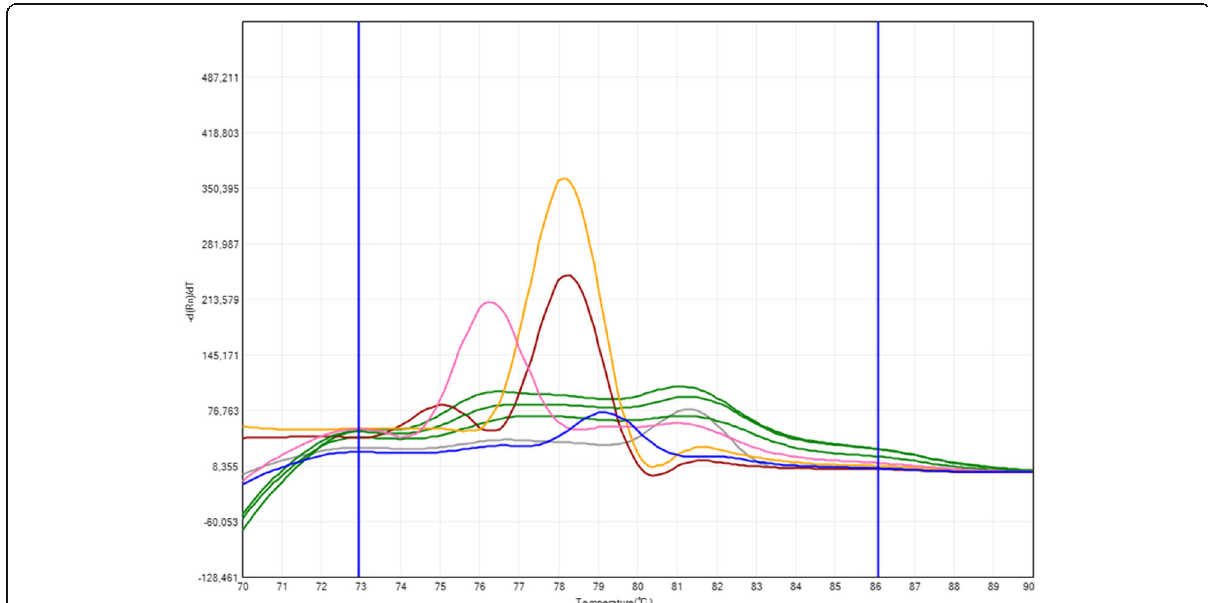
Fig. 5 Derivative melting curve showing the melting peaks of mutant PCR products. The peaks represent the melting temperature of the specific amplified target. HRMA was performed to allow the identification of the mutations when